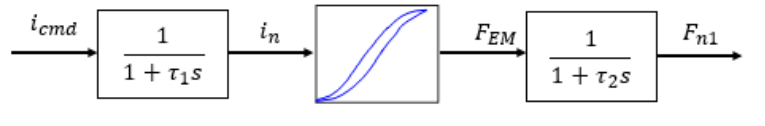
Figure 15. Compression force of the primary clutch.